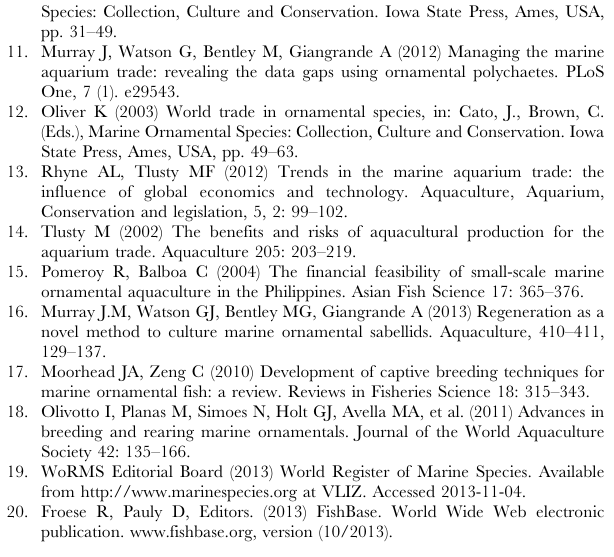
Table S1 Demographic and survey questions asked of responding hobbyists. Multiple-choice restricted and